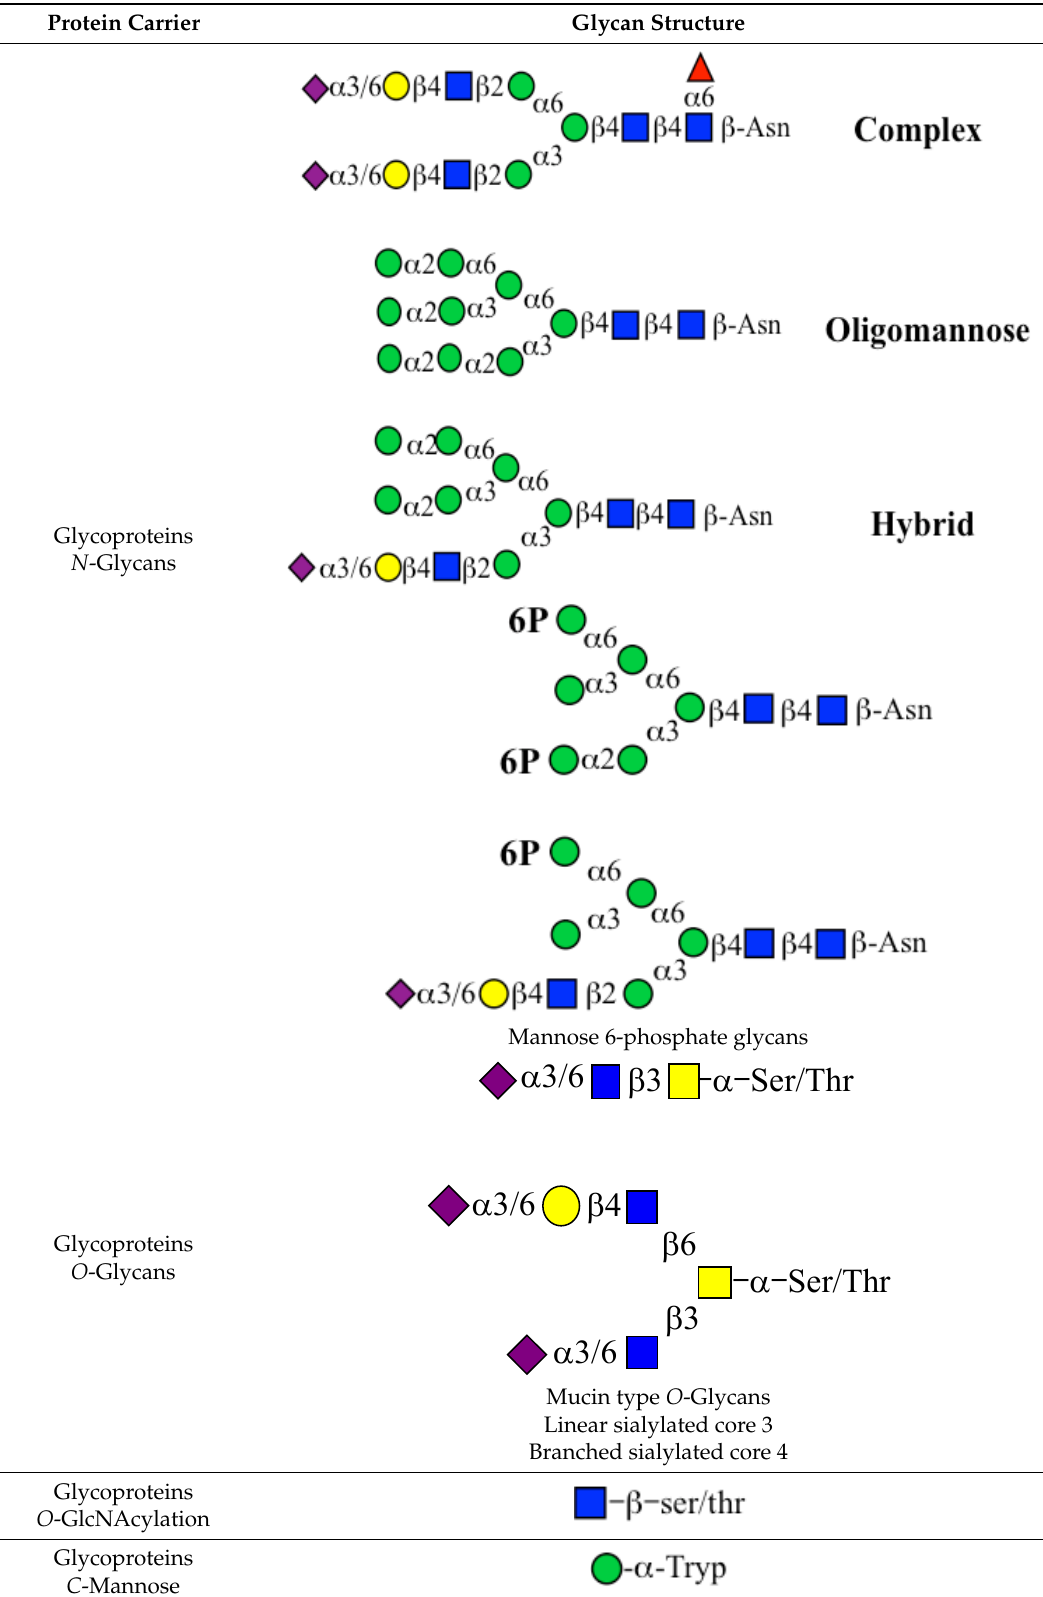
Table 4. Protein Glycosylation Patterns.